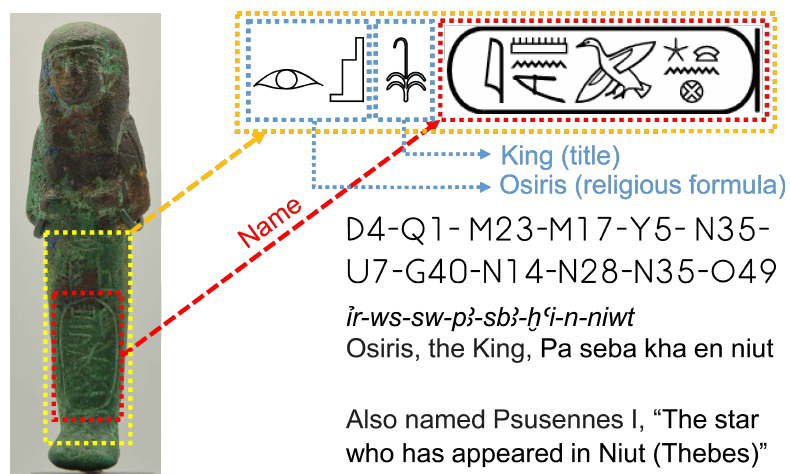
Figure 7. Hieroglyphic inscription, using the Gardiner code [40], representing the title of the King Psusennes I. Private